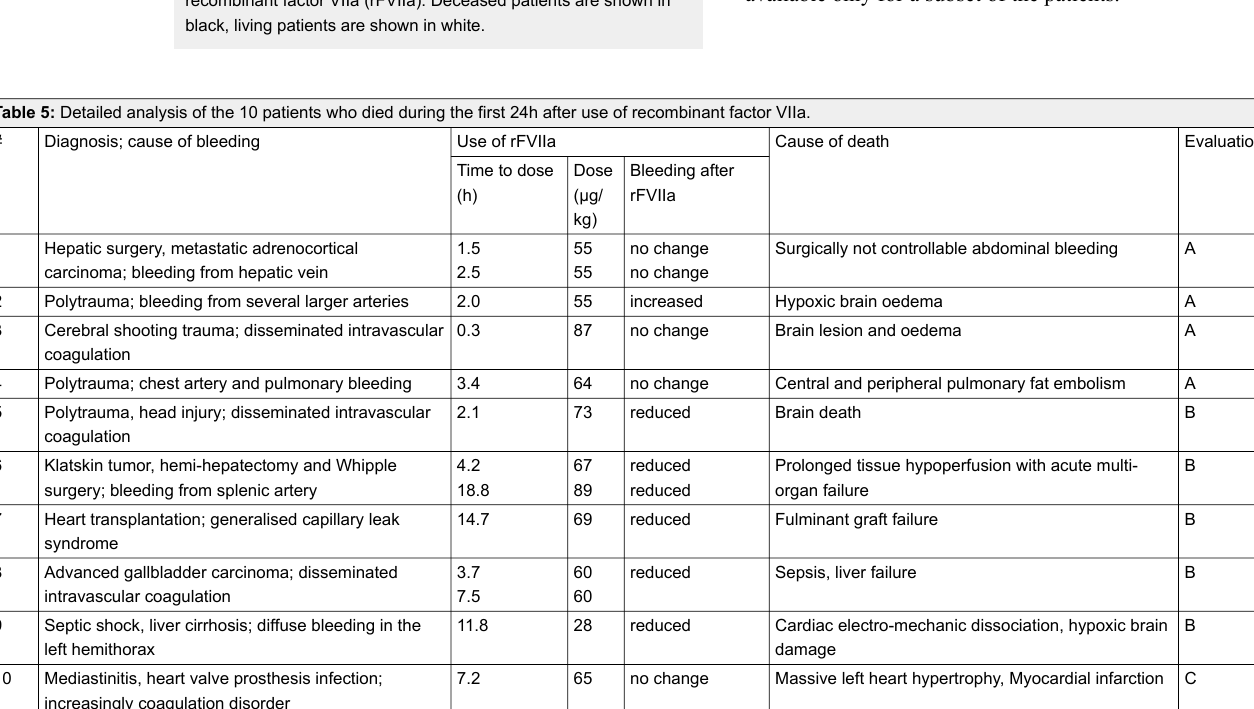
Table 5: Detailed analysis of the 10 patients who died during the first 24h after use of recombinant factor VIIa.